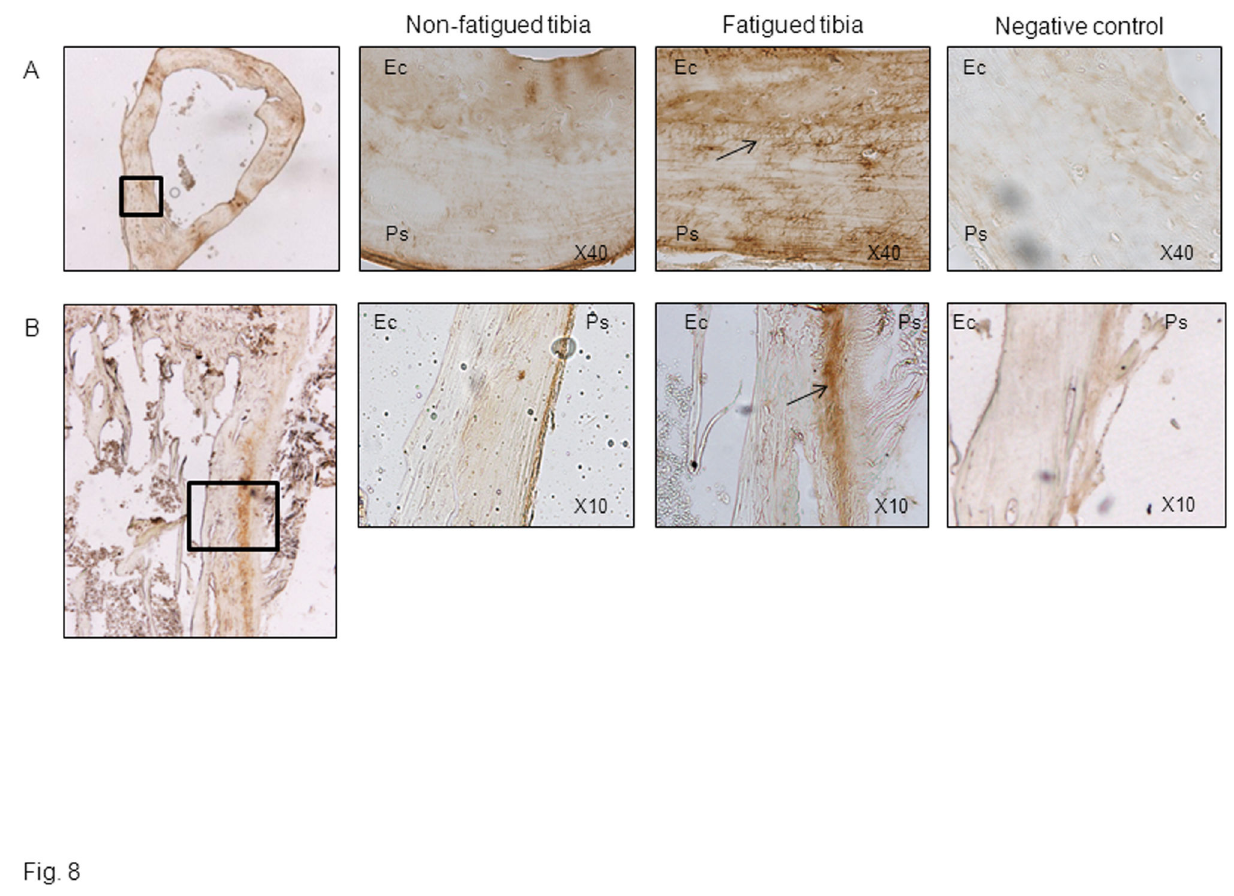
Figure 8. Fatigue loading stimulates periostin expression in cortical bone. Immunohistochemical staining of periostin expression in cross sections (A) and longitudinal sections (B) of the loaded and non-loaded midshaft tibia 3days after fatigue. Magnified images of the cortical region underlying soft calluses are also shown. Note the presence of periostin into osteocyte canaliculae of the fatigued tibia (A, arrow), as well as in the periosteum (Ps) of fatigued tibiae, whereas weak or no staining is detectable at endocortical surfaces (Ec).